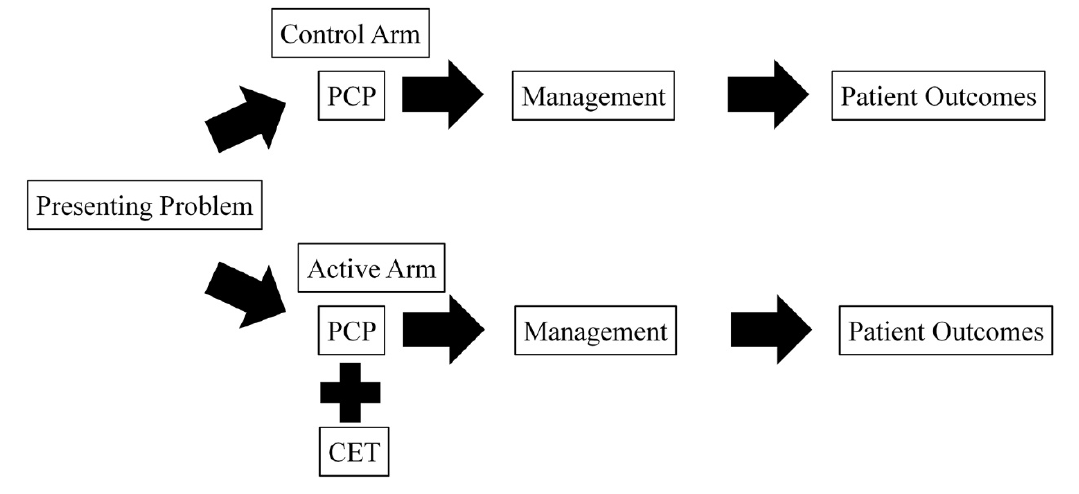
Figure 1 Model of the cluster-randomized pragmatic design